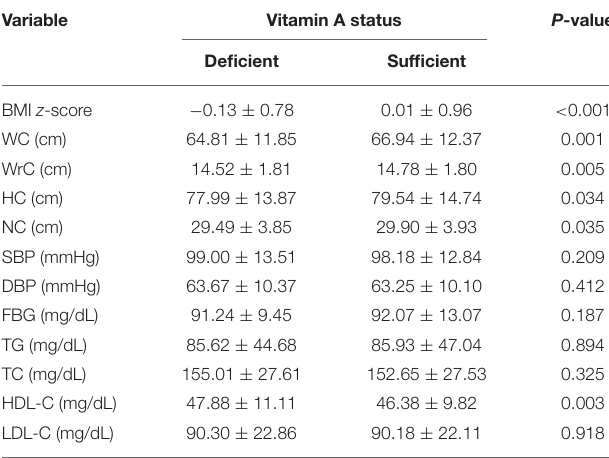
TABLE 2 | Baseline characteristics of study